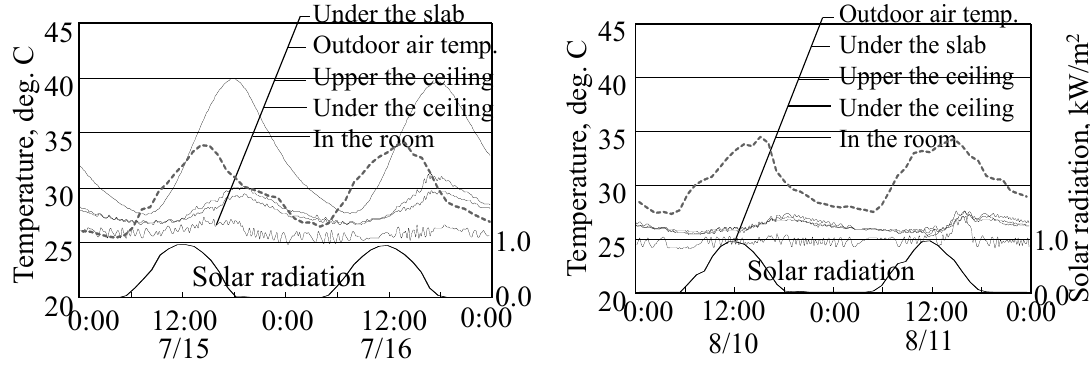
Figure 3. Measurement results for temperature under slab, and above and under suspended ceiling in room 1; outdoor air temperature; and solar radiation. left : Before painting; right : After painting.